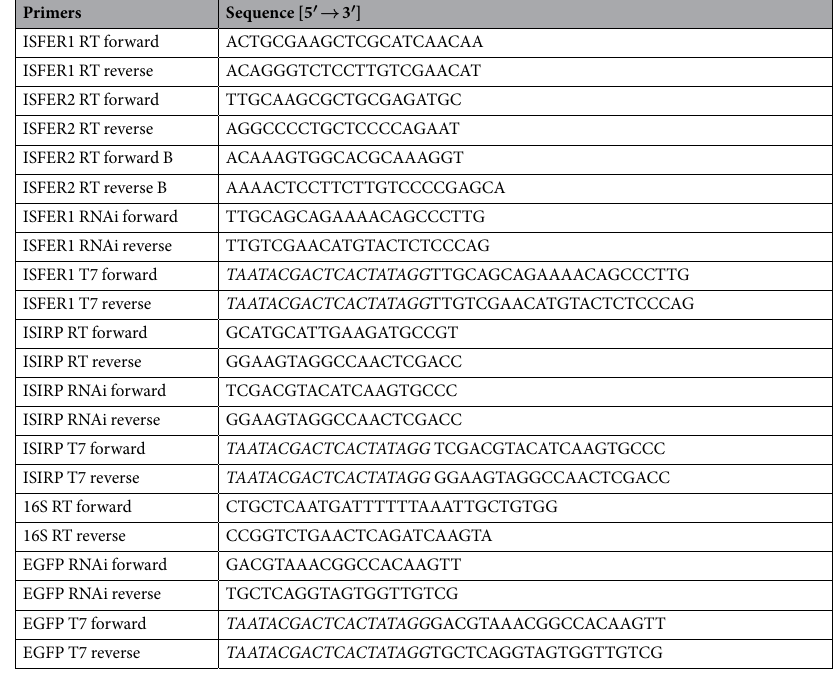
Table 7. Gene-specific primers used in this study. Italics denote T7 promoter